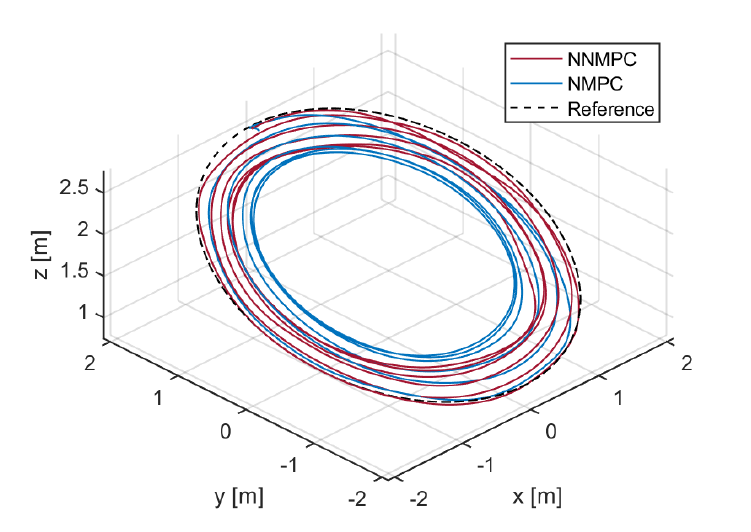
Figure 12. Sinusoidal trajectory tracking result for PID, NMPC, and NNMPC controllers in three axes from real-world experiment.